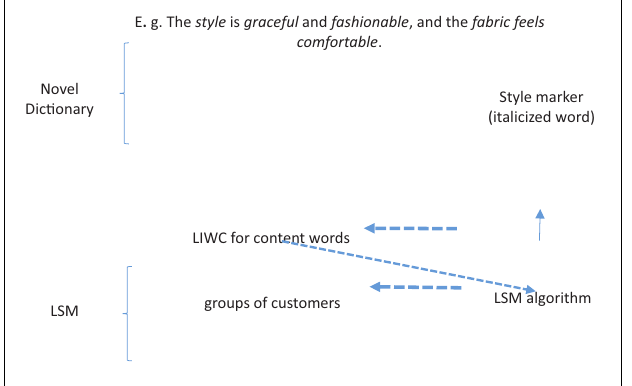
FIGURE 1 | Overview of the research